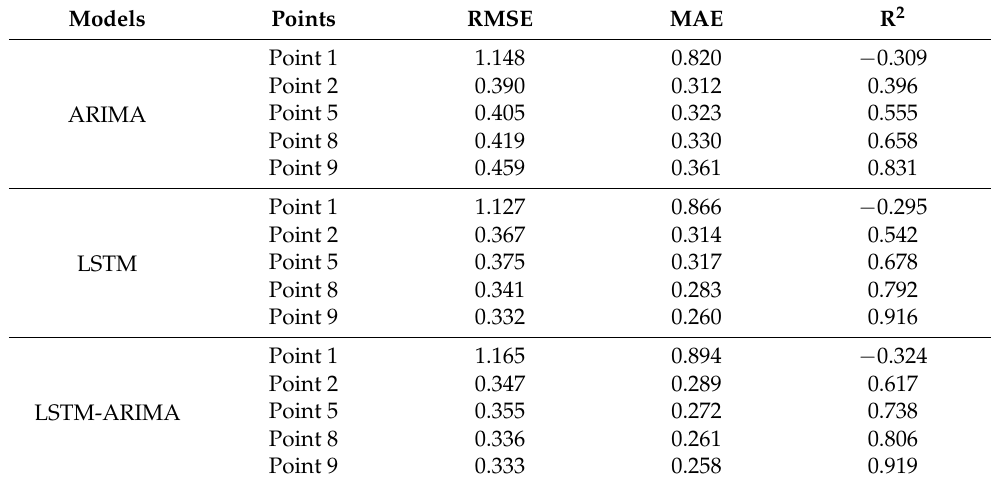
Table 2. Summary of lithological distribution of typical dumping bodies.